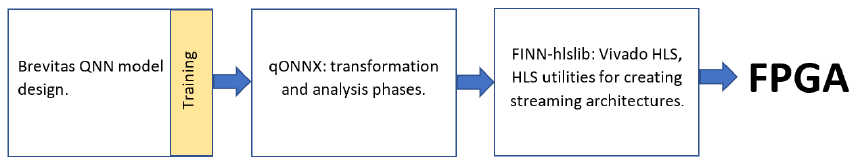
Figure 2. Workflow from Brevitas to the